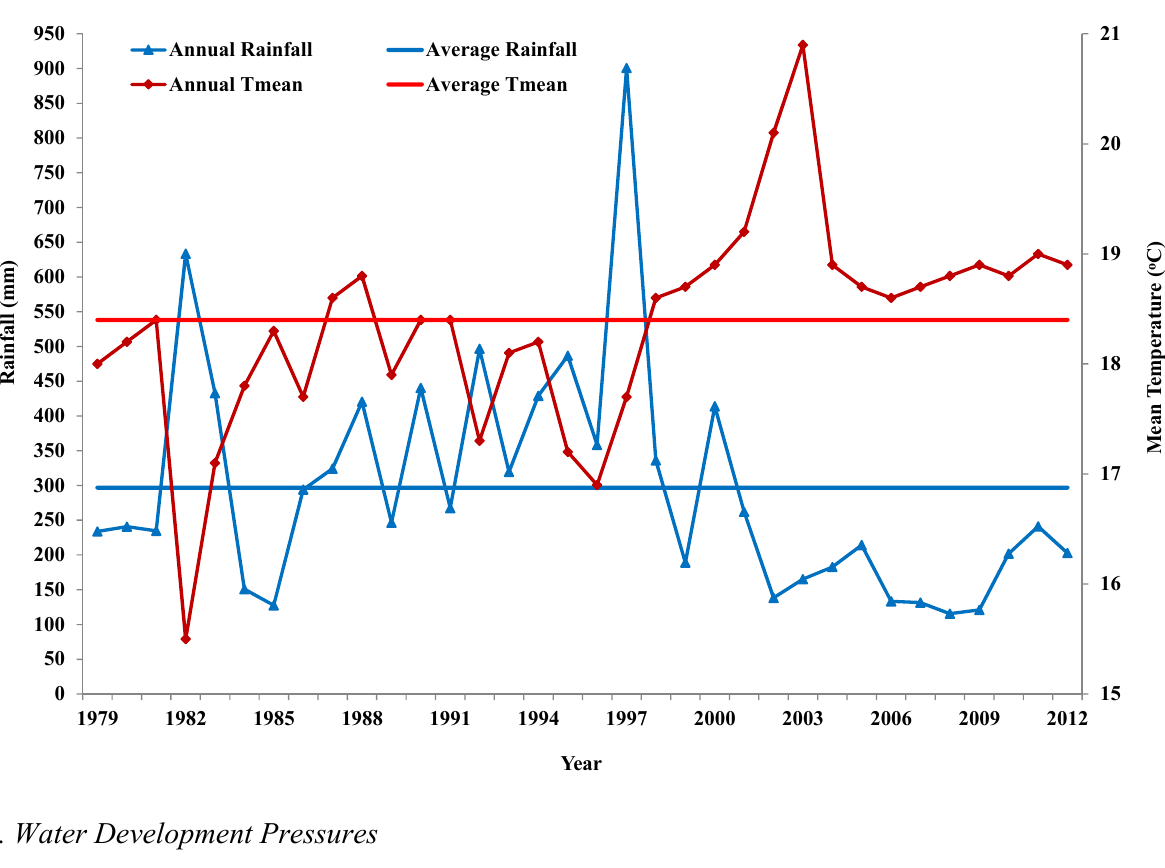
Figure 2. Trends in mean air temperature (Tmean) and annual rainfall in Saiq Meteorology Station (World Meteorological Organization (WMO) Index: 41254, Universal Transverse Mercator (UTM) coordinates Latitude: 23°04'28.33" N, Longitude: 57°38'46.63" E, Elevation: 1986 m) from 1979 to 2012 (Data source: